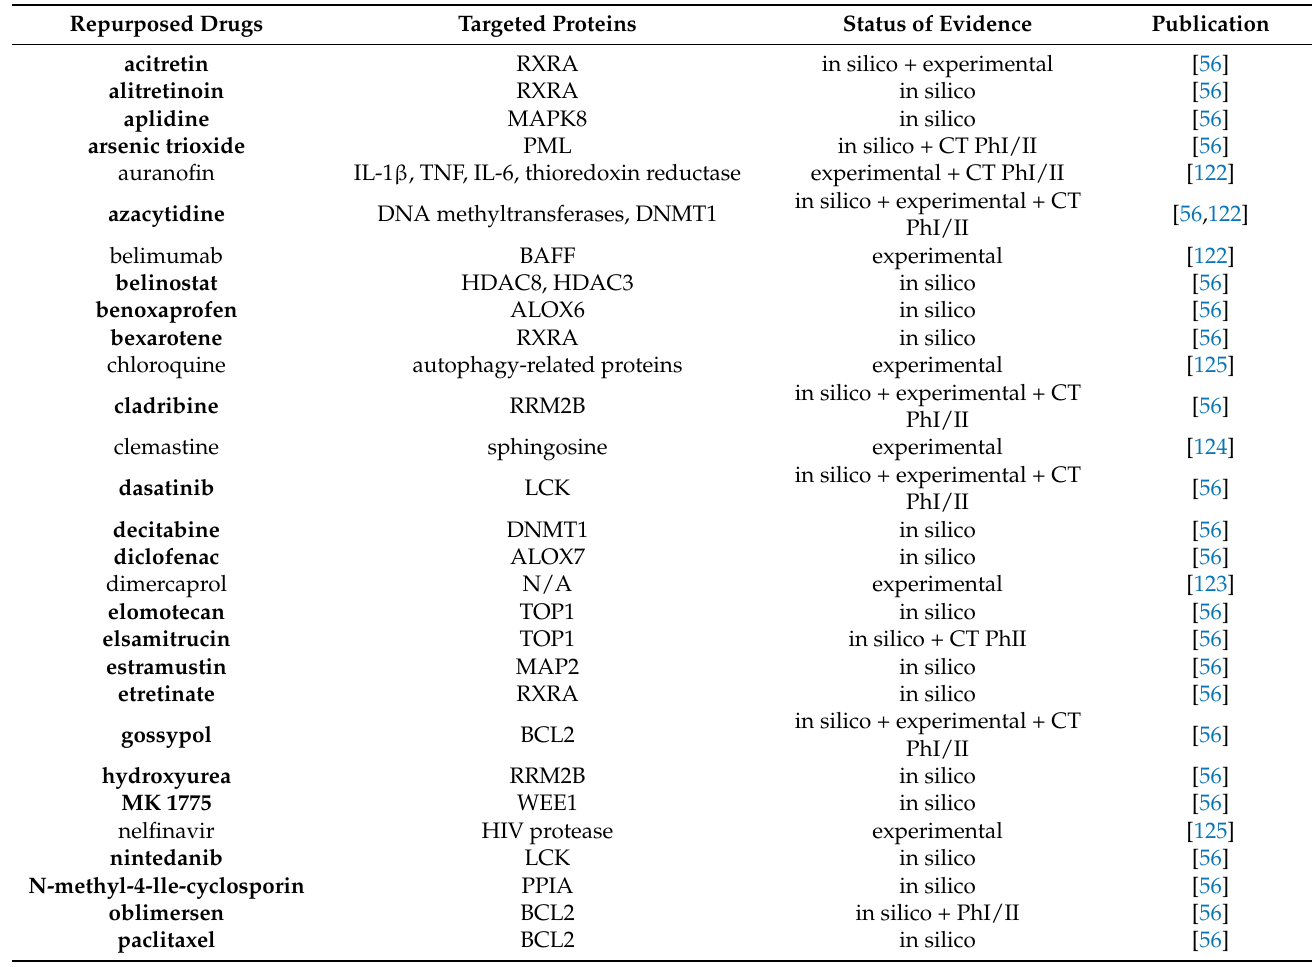
Table 1. Repurposed drugs in CLL. Overview of already proposed repurposed drugs in CLL, showing the possible molecular targets (targeted proteins); the quality of scientific evidence to assess the drug repurposing evidence level (status of evidence); and the publication referring each repurposed drug (publication). The proteomics-based repurposed drugs are indicated in bold. CT: clinical trial; PhI/II: phase